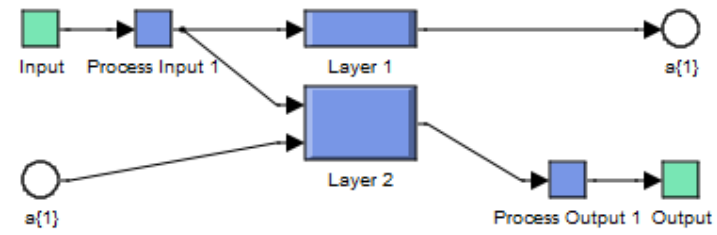
Figure 10. Structure of the neural controller of the ANFIS controller.